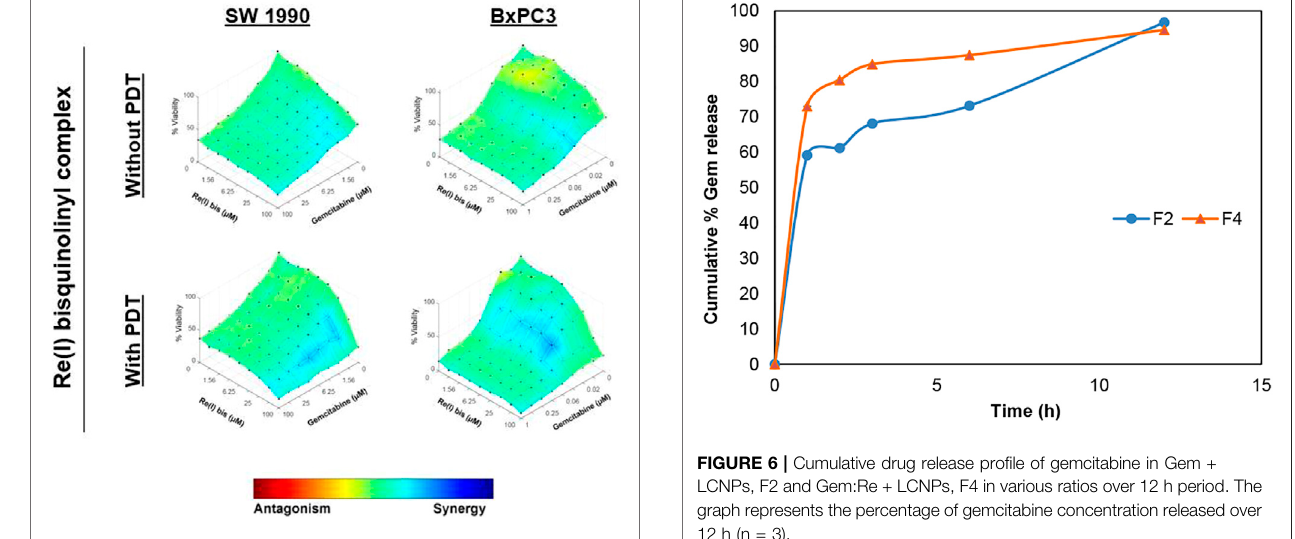
FIGURE 4 | Combinatory effects of gemcitabine with Re(I) bisquinolinyl complex in pancreatic cancer cells (HSA model).